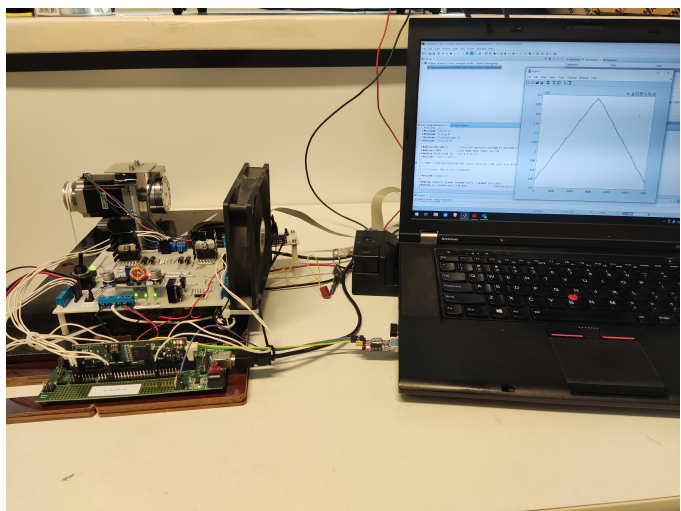
Figure 12. Photo of the test setup. The acquired shaft position dataset can be seen on the PC screen.